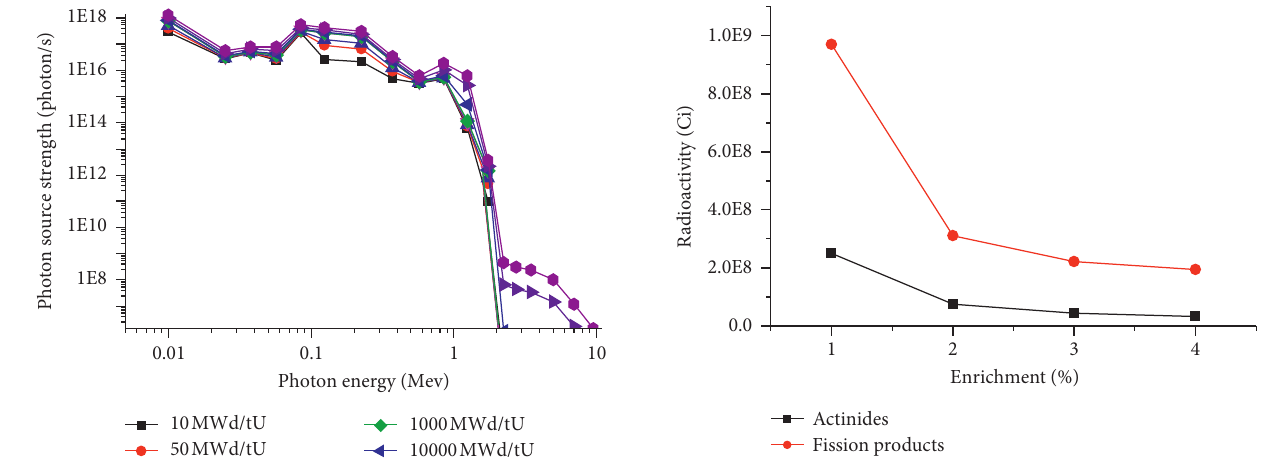
Figure 3: The radioactivity of actinides and fission products with different enrichments.